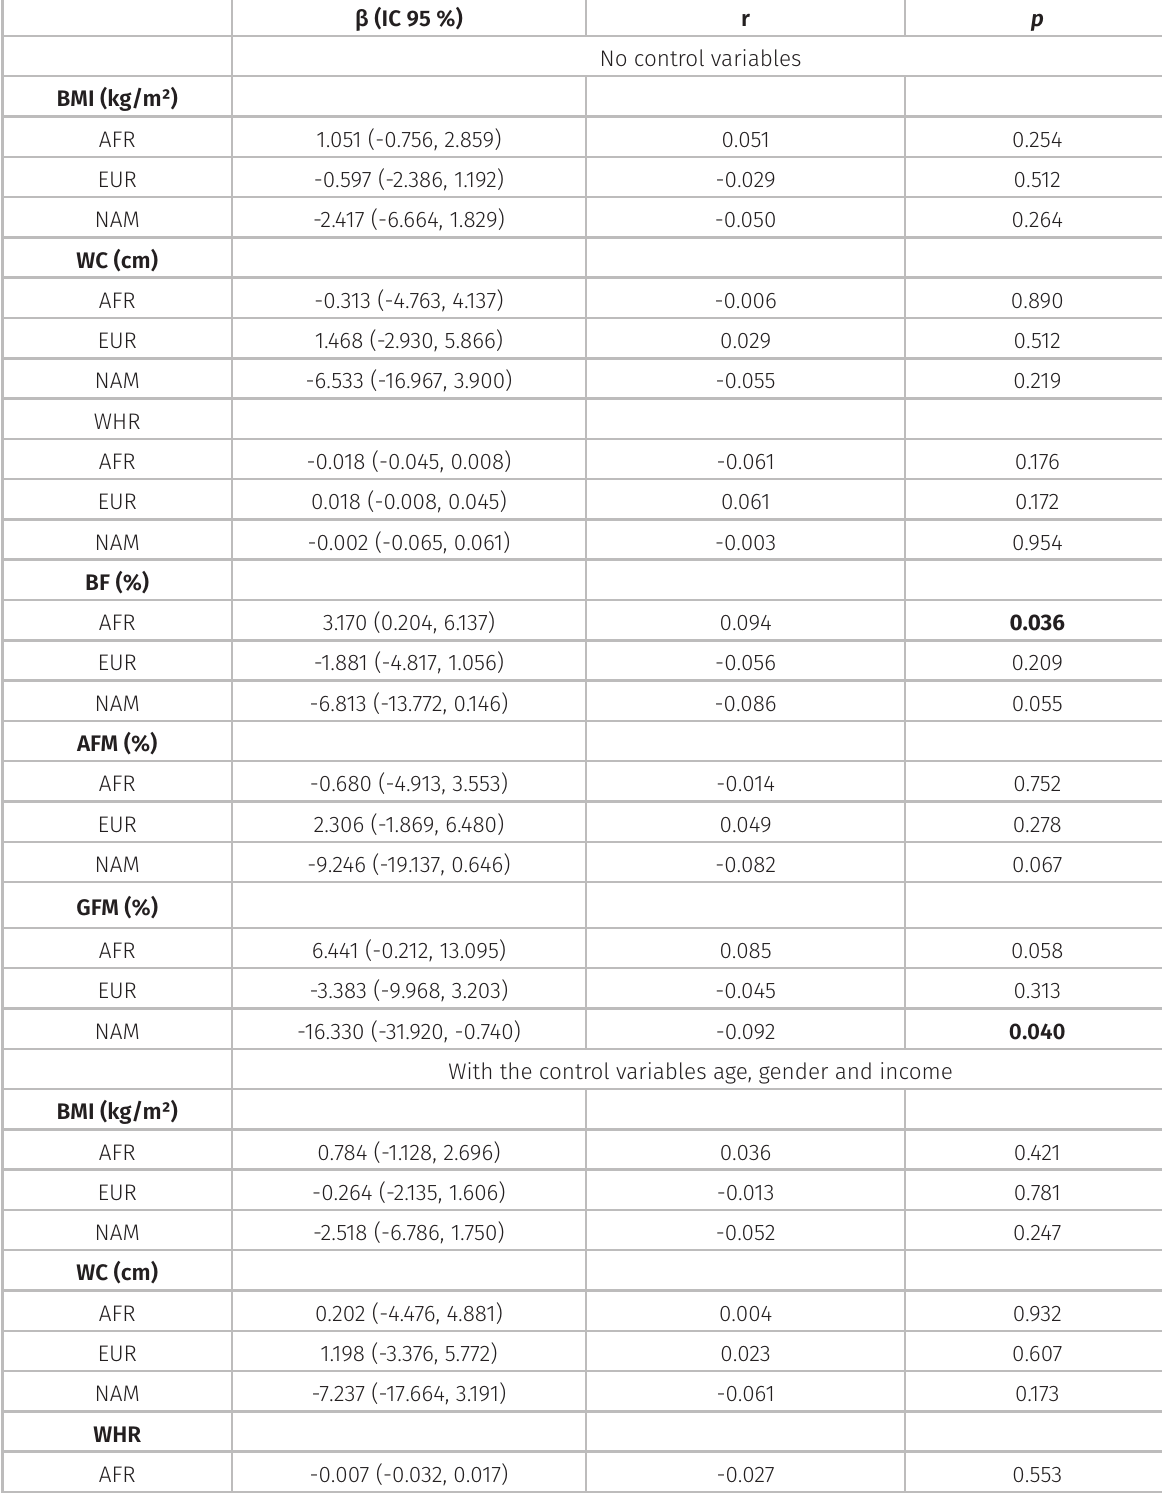
Table III. Multiple linear regression association and correlation analyses results, as well as confidence intervals and p -values, between the genomic ancestries and the obesity-related